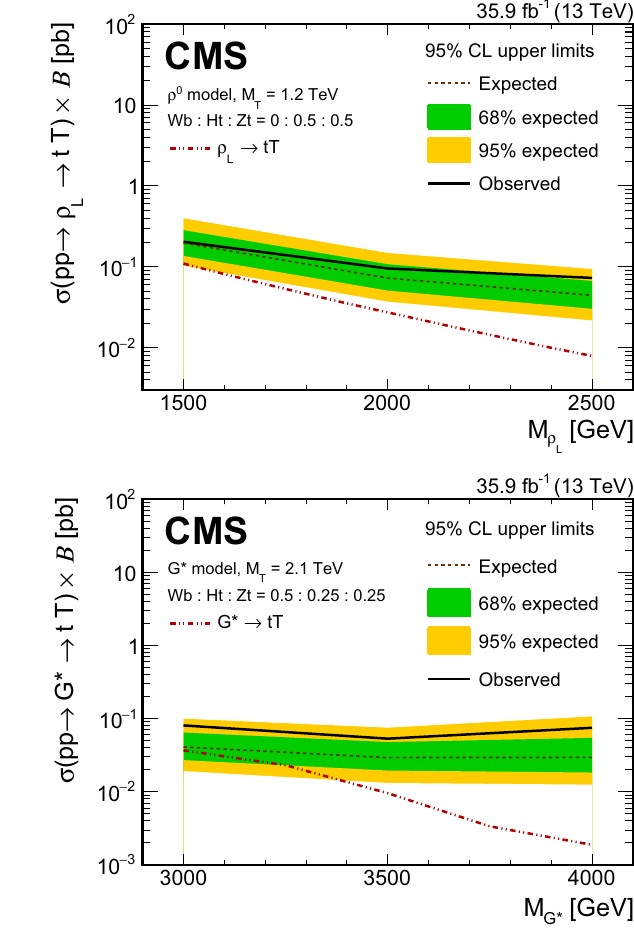
Fig. 8 Exclusion limits at 95% CL on the product of the cross sec- tion and branching fraction for three T masses of 1.2TeV (upper row), 1.5TeV (lower left), and 2.1TeV (lower right), as a function of the resonance mass. The branching fraction is defined as B = B ( T →